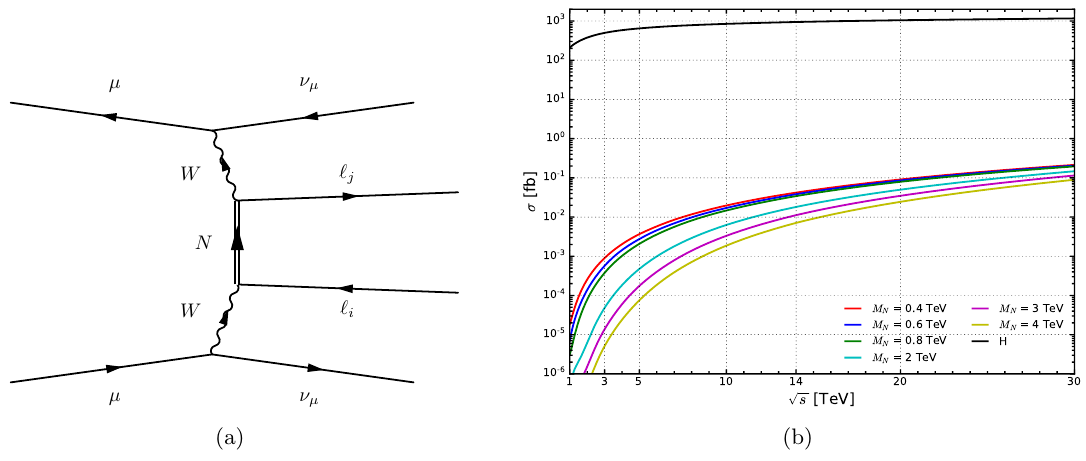
‘ (cid:0) production via t -channel exchange of a heavy i j p s [TeV] for mass M N